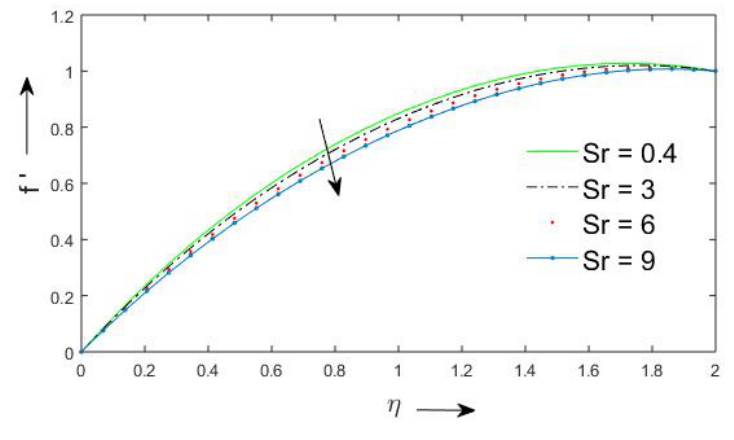
Figure 2: Distribution of velocity due to